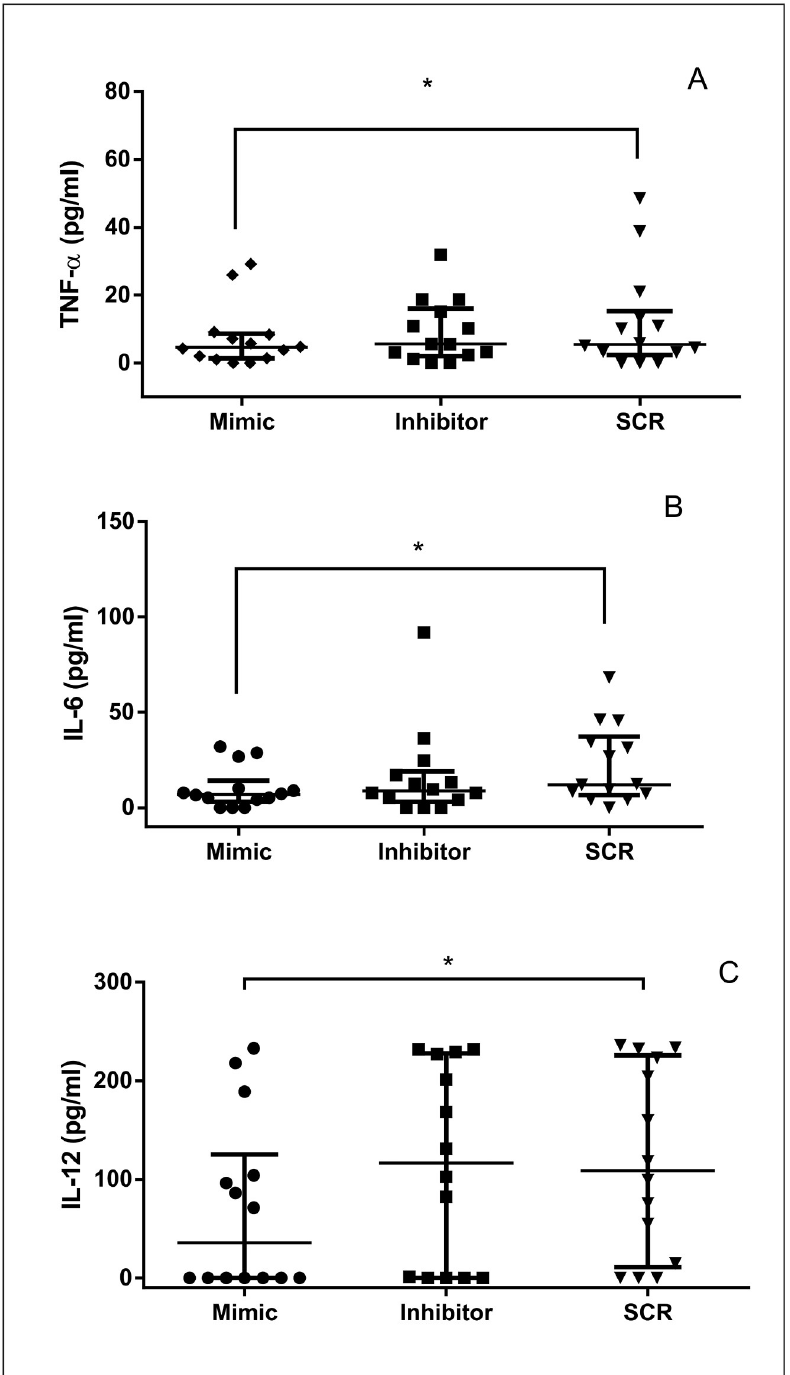
Fig 5. Concentration of TNF- α , IL-6, and IL-12 after transfection in SL with miR-148a mimic or inhibtor. TNF- α (A), IL-6 (B), and IL-12 (C) were quantified in SL supernatants cultures from CanL group (dogs naturally infected by L . infantum ) and transfected with miR-148a mimic or inhibitor, or SCR in the presence of Hiperfect following 48 h in the culture at 37˚C and 5% CO2. Bars represent concentration median values of TNF- α (4,570, 5,609 and 5,490), IL-6 (7,072, 8,885 and 12,25) and IL-12 (35,66, 116,8 and 108,7), 25th percentile interquartile range of TNF- α (1,332, 2,065 and 2,376), IL-6 (3,273, 3,273 and 6,706) and IL-12 (0,0, 0,0 and 11,07) and 75th percentile interquartile range of TNF- α (8,628, 16,06 and 15,30), IL-6 (14,36, 19,10 and 37,42) and IL-12 (125,2, 227,7 and 225,7) of mimic, inhibitor and SCR treatments, respectively. Symbols represent data from individual animals. Asterisks represent significant differences (Friedman with Dunn’s multiple comparison test, p = 0.03 (A), p = 0.01 (B), p = 0.007 (C)).